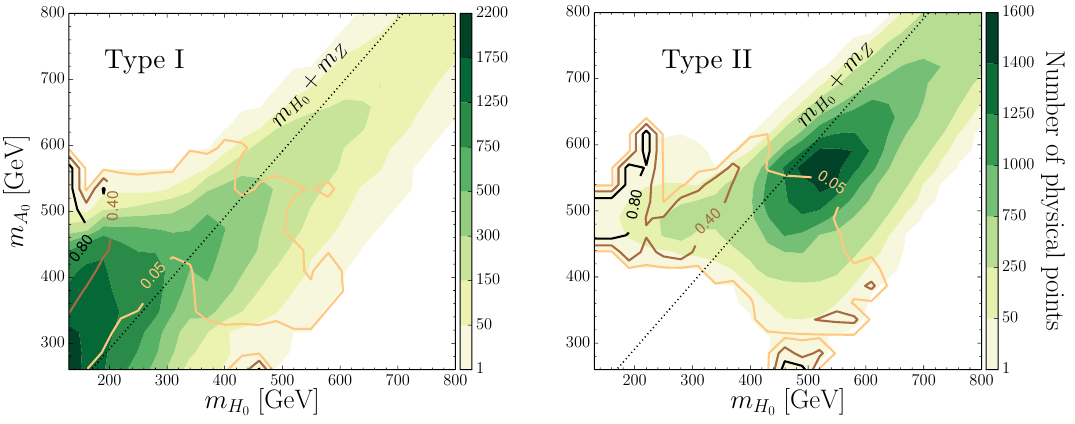
Figure 5 . Distribution of physical points and (cid:12)rst order EWPT is clearly favoured by a splitting m A only scalar whose mass is free to be large, 7 and (cid:12)gure 4 con(cid:12)rms that a rather heavy 8 A